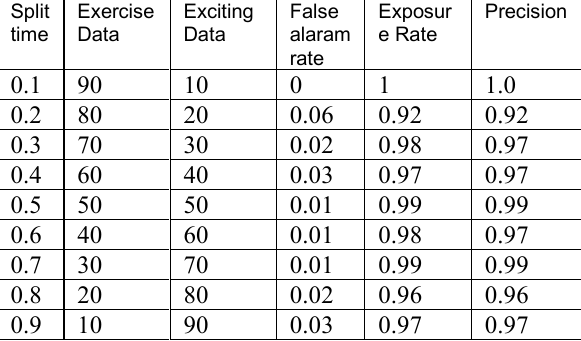
Table 1. Experimental